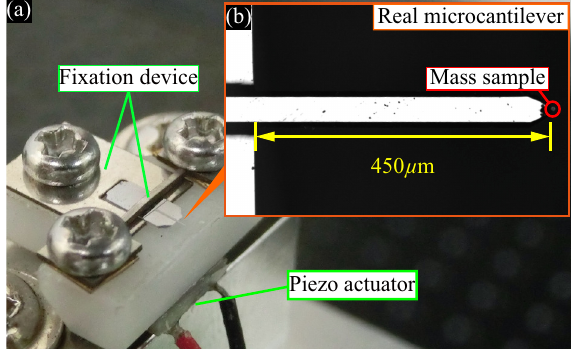
Figure 4. Experimental setup; ( a ) Piezo actuator and fixation device; ( b ) Real microcantilever. Minute particles with a mass of 17 ng as a mass sample on the real microcantilever which had dimensions of 450 µ m × 55 µ m × 4 µ m and eigenfrequency of 24.7 kHz. The piezo actuator had a piezoelectric constant d 33 of 600